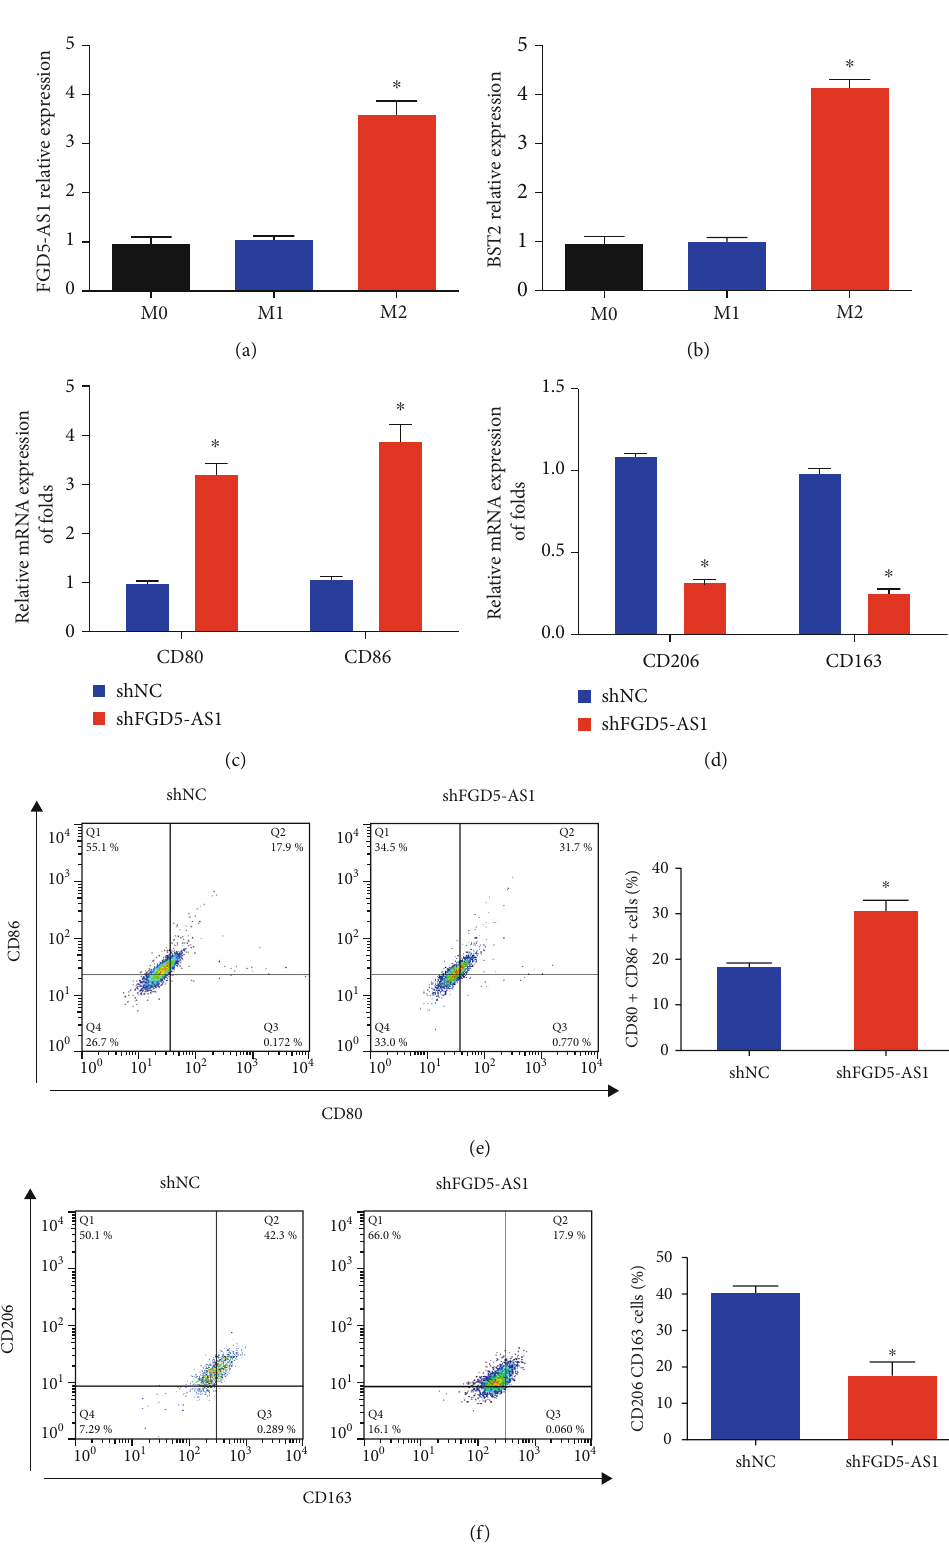
Figure 3: E ff ects of FGD5-AS1 on M2-like polarization of macrophages. (a) The expression of FGD5-AS1 was increased in M2 macrophages. (b) The expression of BST2 was upregulated in M2 macrophages. M0 cells were transfected with FGD5-AS1 shRNA. (c) Expression of M1 markers (CD80 and CD86). (d) Expression of M2 markers (CD206 and CD163). (e) Flow cytometry analysis of CD80 and CD86 in di ff erent transfectants of M0 cells. (f) Flow cytometry analysis of CD206 and CD163 in di ff erent transfectants of M0 cells. ∗ P < 0 : 05 . Three independent assays were carried